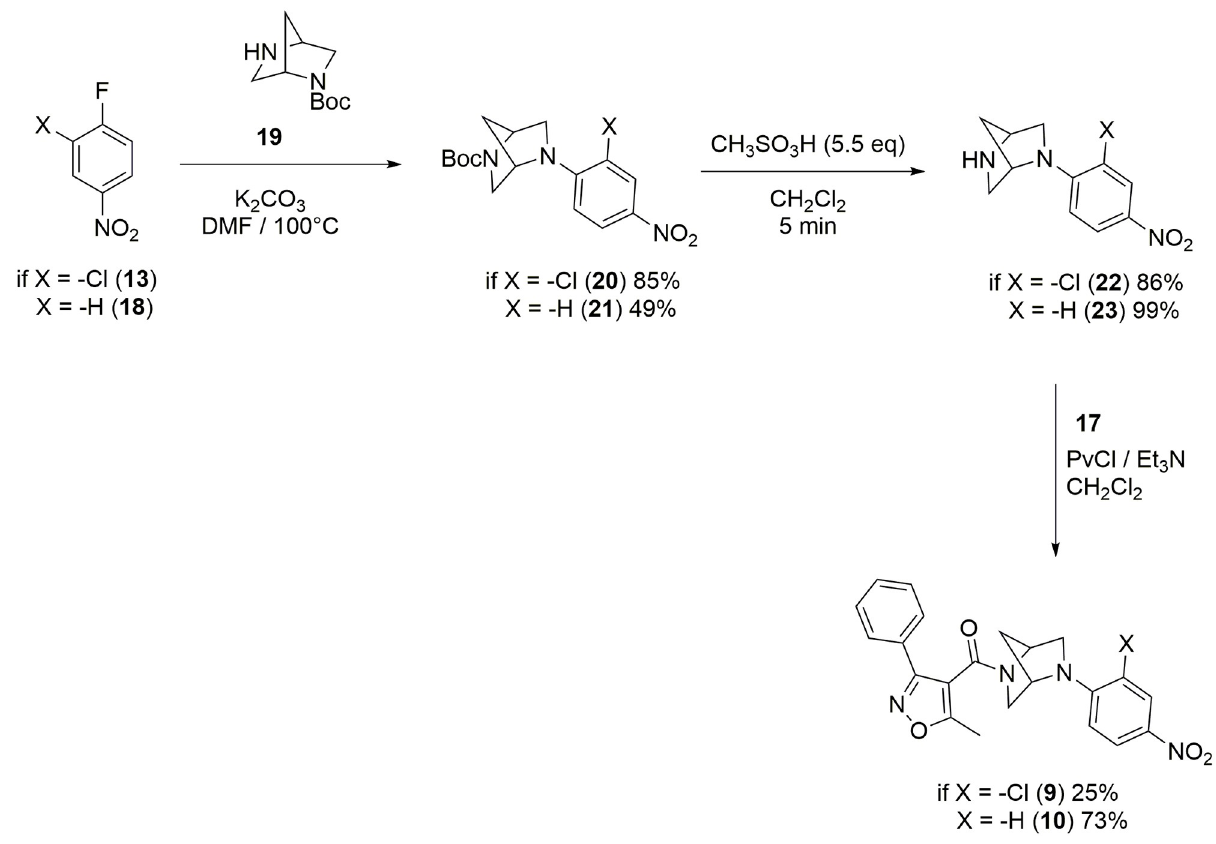
Fig 4. Synthesis of compounds 9 and